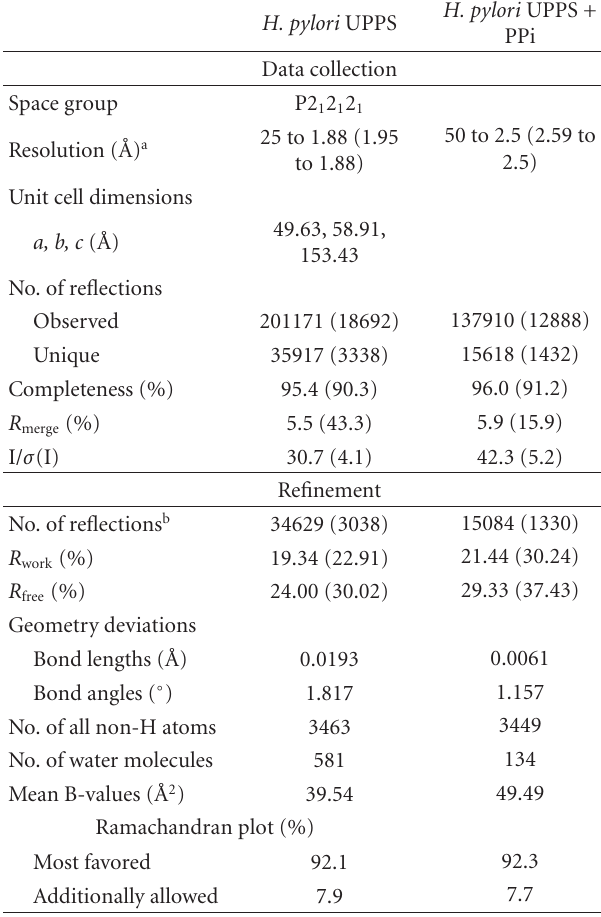
Table 1: Data collection and refinement statistics for the or- thorhombic H. pylori UPPS crystals of the apoenyzme and the com- plex with thiopyrophosphate. C234A mutation was included to pre- vent intramolecular disulfide bond